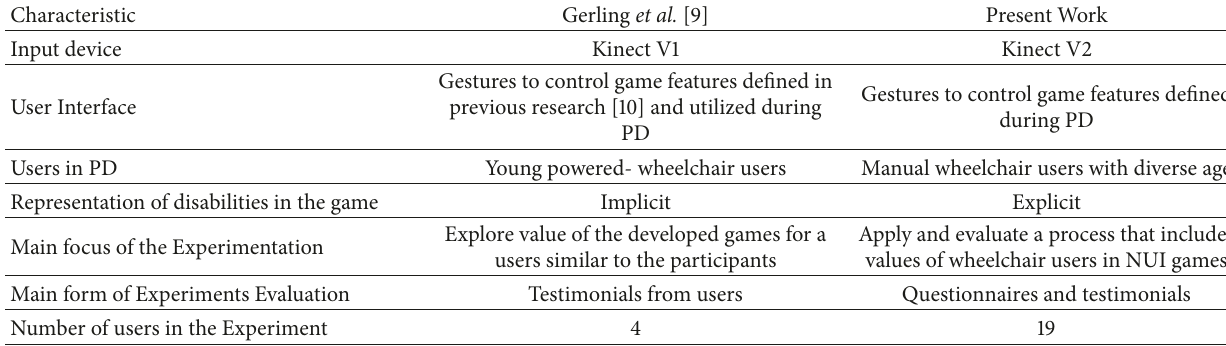
Table 10: Main differences between the present work and its most similar